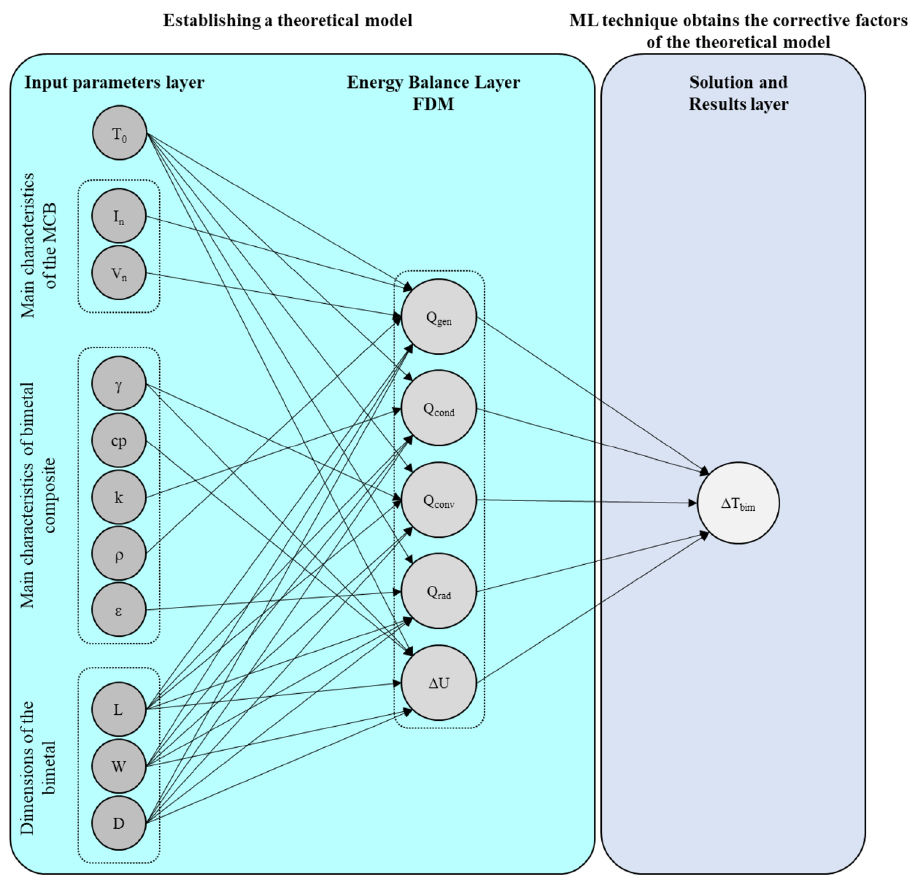
Figure 3. Neural network diagram of the machine learning model of bimetal inside the circuit